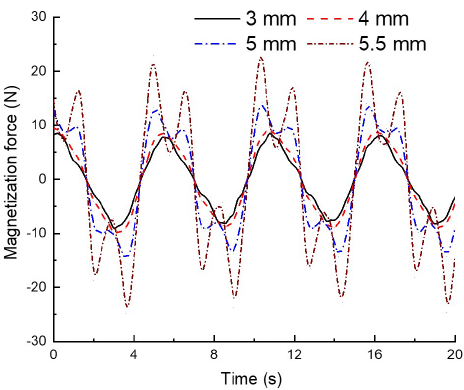
Figure 10. Flux density of different thicknesses. Figure 11. Magnetization force of different